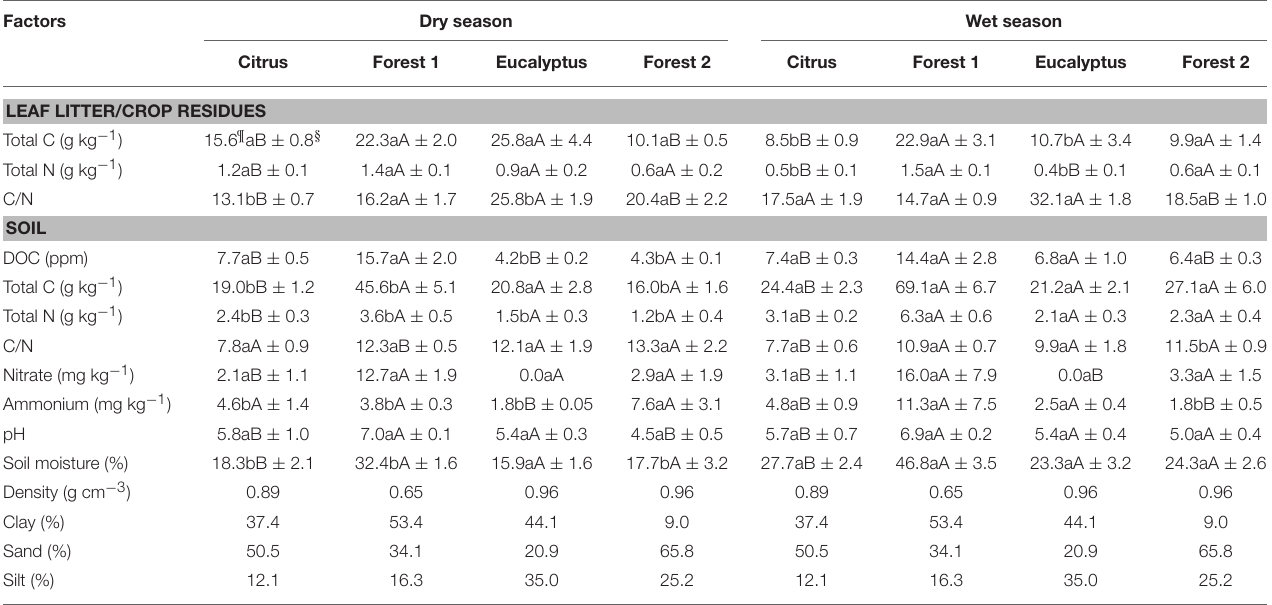
TABLE 3 | Leaf litter and crop residue chemical factors and soil physicochemical factors from Citrus, Forest 1, Eucalyptus and Forest 2 sites collected in the field in dry and wet